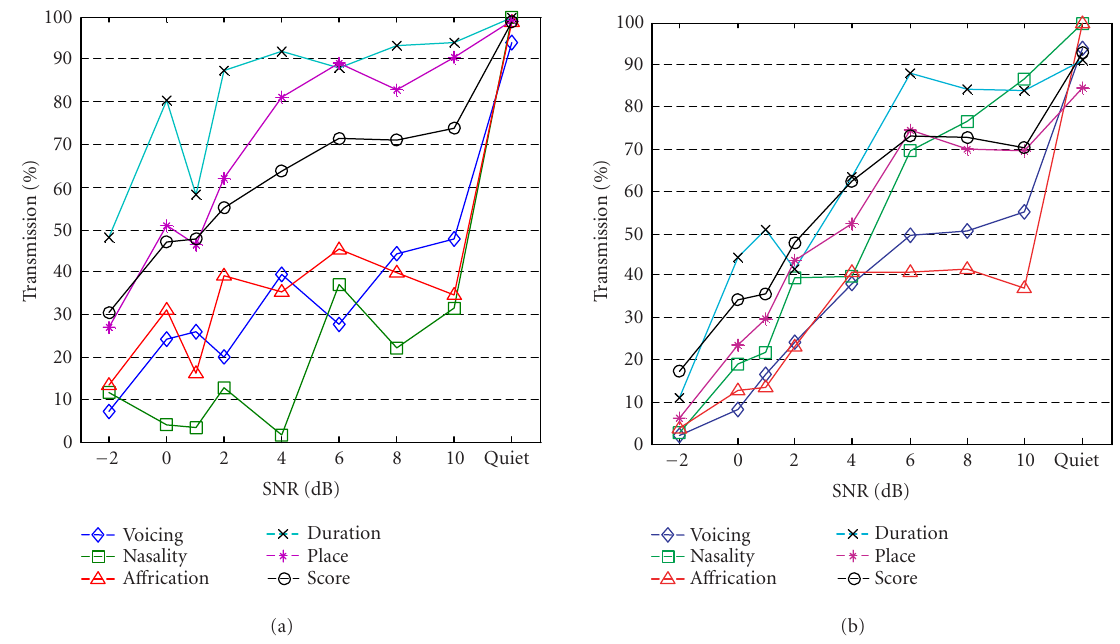
Figure 3: (a) 6/20F consonant information transmission analysis. (b) 8F consonant information transmission